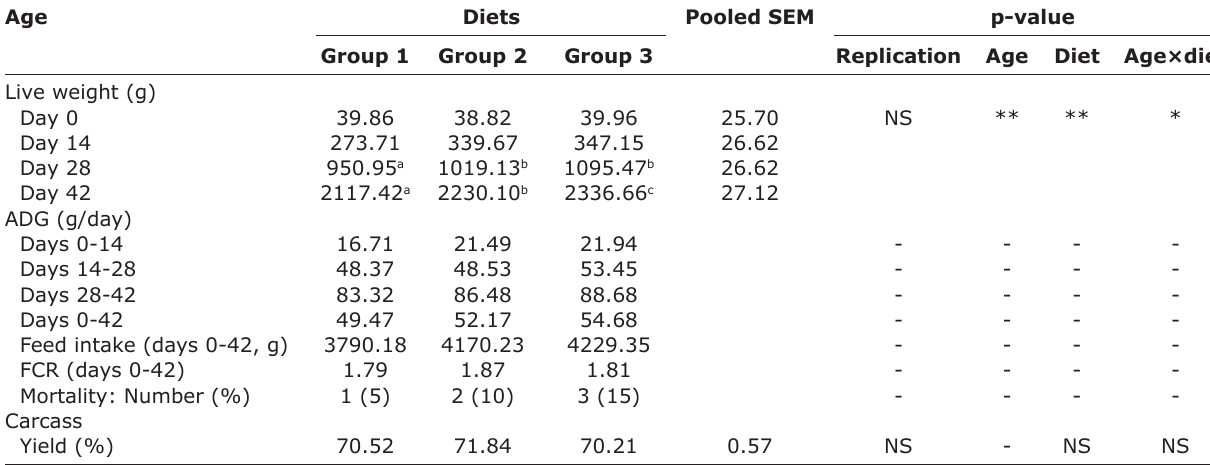
Table-2: Effect of Artemisia or olive leaf powder on growth performance and carcass yield of broilers (mean, pooled SEM). Age